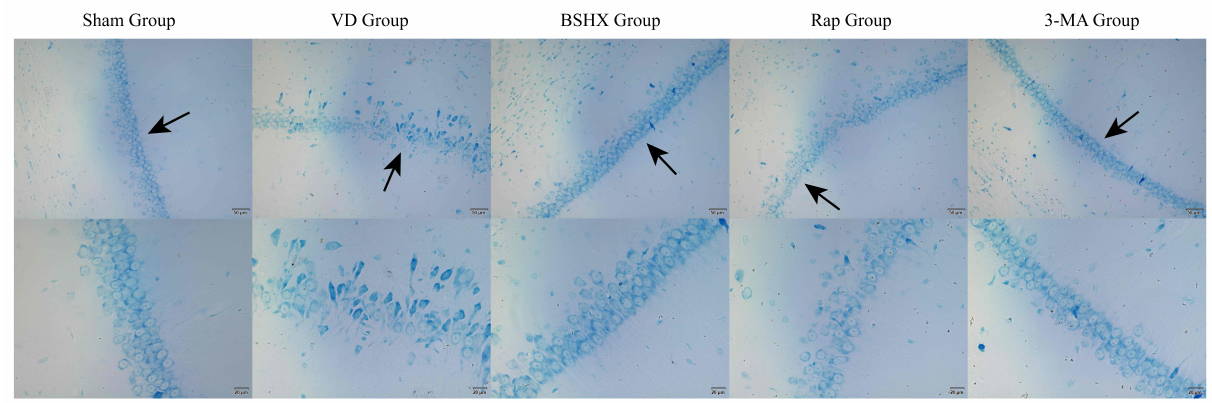
Fig. 7. Pathological morphology of hippocampal CA1 region of rats in each group. Each group had two views, one at low power (200 × ), and the other at high power (400 × ).